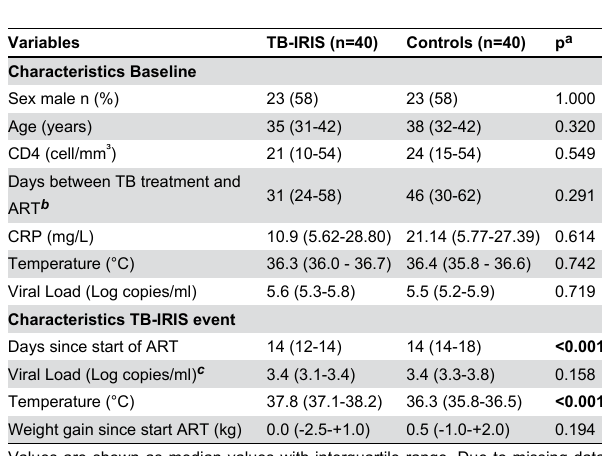
Table 1. Characteristics of TB-IRIS patients and matched